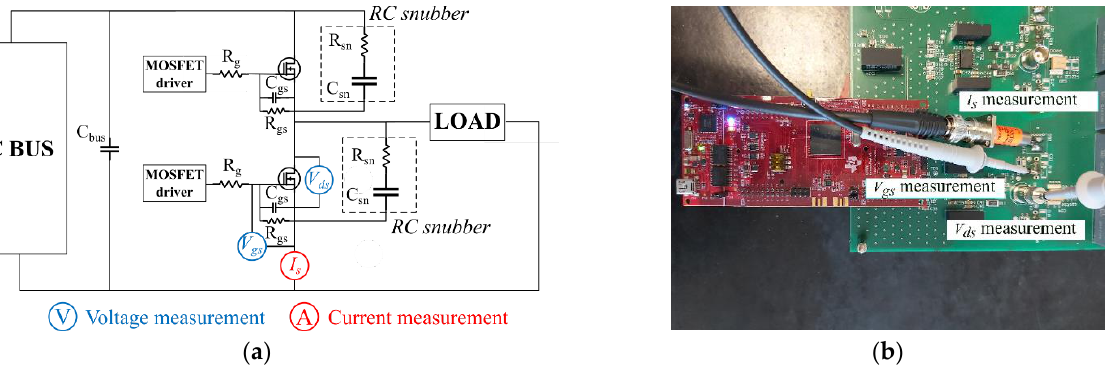
Figure 4. Test bench for measurement of switching waveforms: ( a ) block diagram of a half-bridge and positioning of measuring probes; ( b ) PCB detail with location of current shunt and voltage probes.